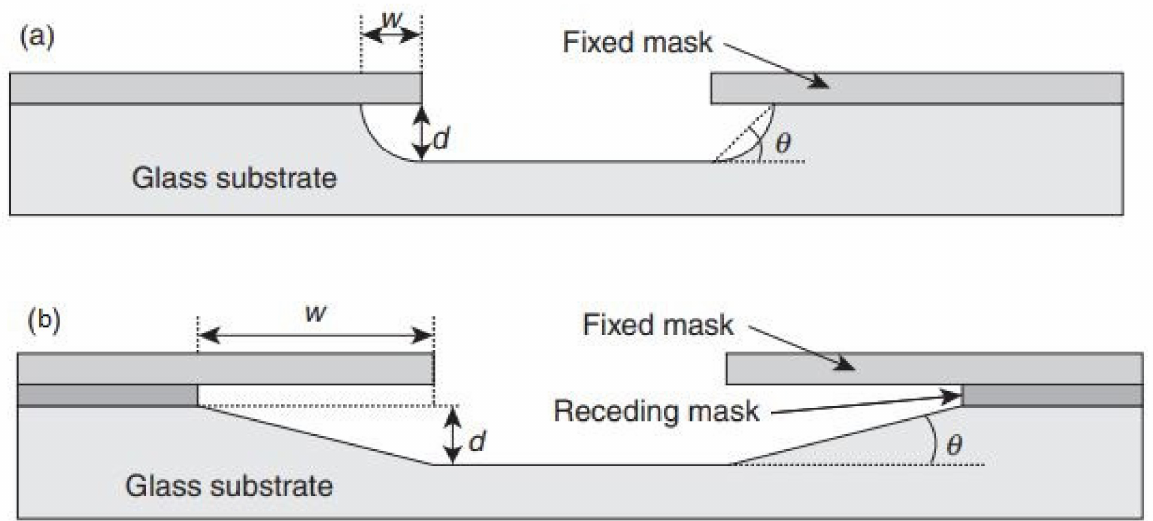
Figure 9. Schematic illustration of etching of glass by ( a ) Si passive etch mask, and ( b ) Schematic representation of etching of glass with a bilayer mask made of a fixed mask and a receding mask [148]. (Adapted with permission from Ref. [148]. Copyright 2013